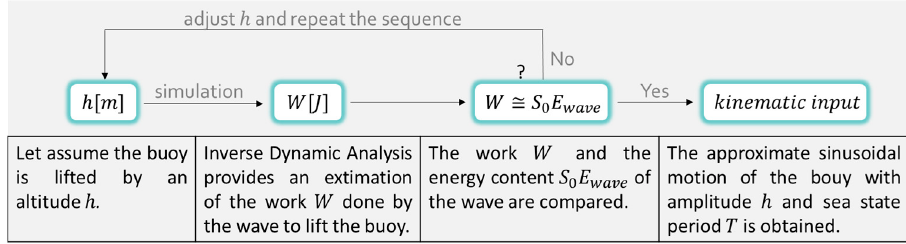
Figure 3. Volume of water displaced by the floating buoy.